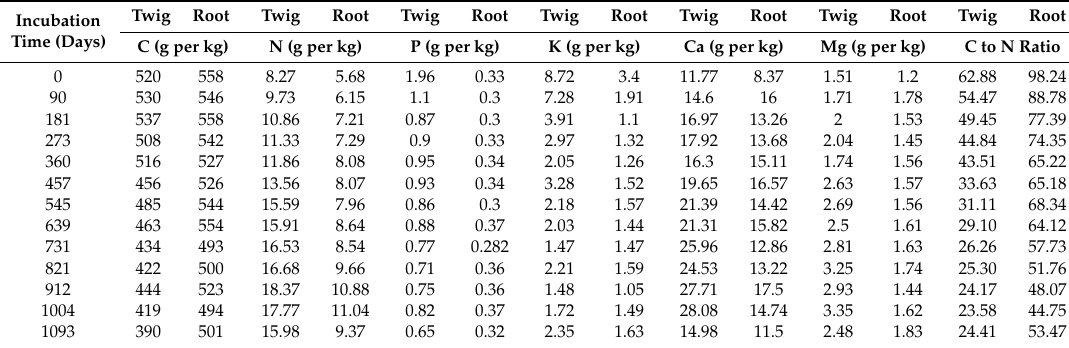
Table 2. Initial chemistry and chemical dynamics in twigs and small roots from Parashorea Chinensis Wang Hsie litter monitored during the course of decomposition (for 1093 days) in Mengla county, Xishuangbanna, China. Values are laboratory duplicate